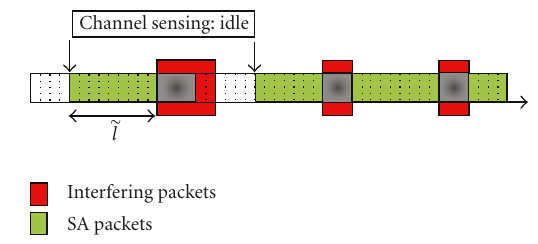
Figure 6: It is possible to have two interfering packets during the transmission time, however the probability of such events is